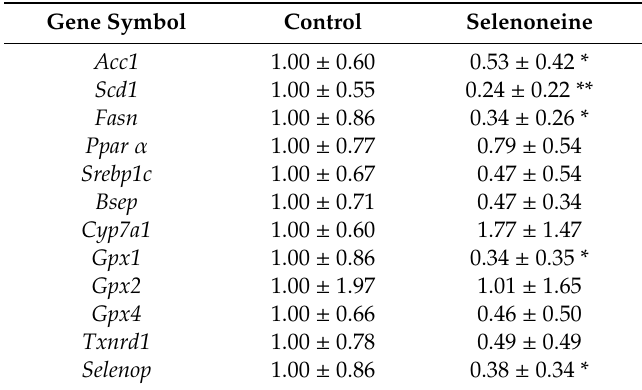
Table 3. Hepatic mRNA levels of selenoprotein and lipid-related